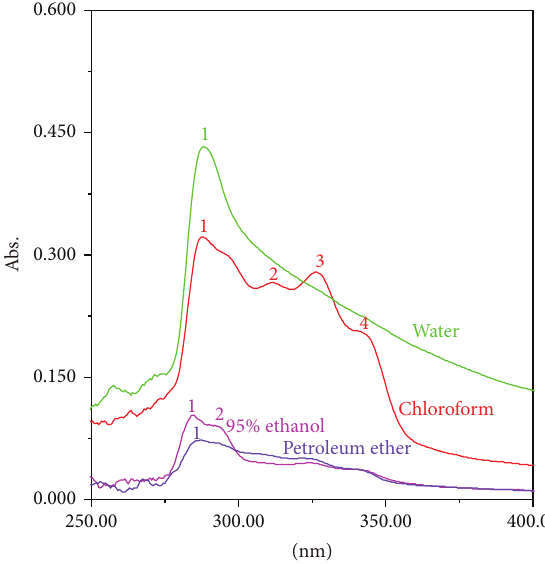
Figure 1: UV spectra of different extraction